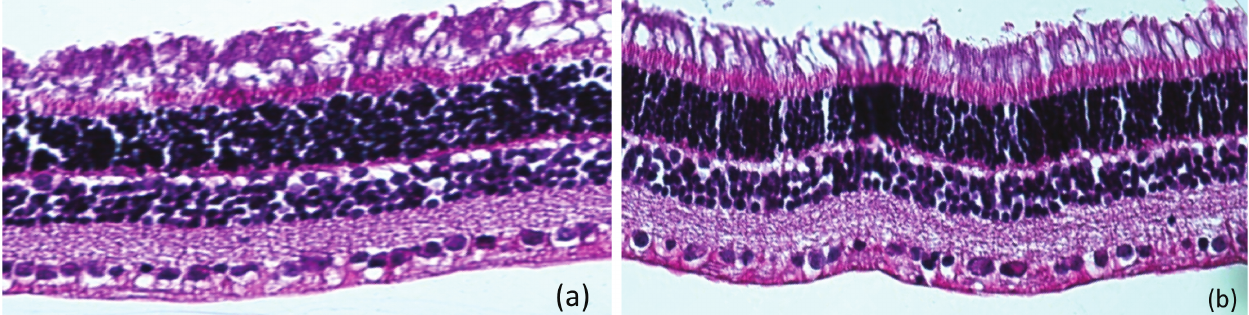
Figure 1. Representative histopathological sections from injected eyes four weeks after injection: there is preservation of the retinal cytoarchitecture without loss of the inner and outer nuclear layers or the inner and outer plexiform layers in both Avastin- injected (a) and Stivant-injected eyes (b) (Staining: hematoxylin and eosin [H&E], magnification: ×